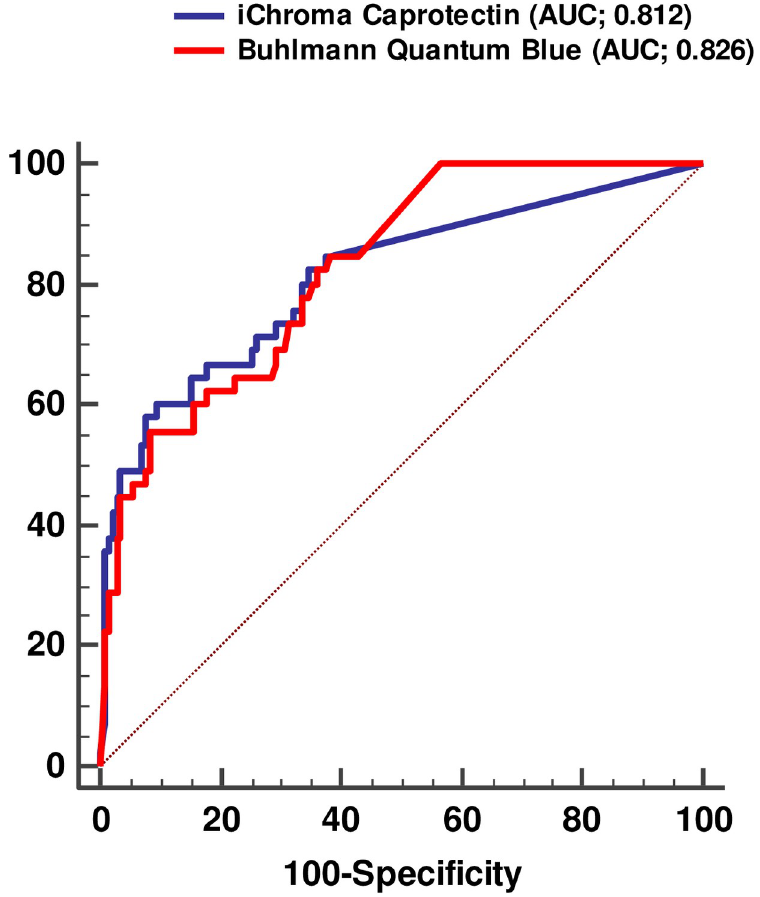
Fig 3. ROC curve analysis of iChroma calprotectin and Buhlmann Quantum Blue assays for detecting active IBD. The AUCs were 0.812 and 0.826 for iChroma and Buhlmann Quantum Blue, respectively.